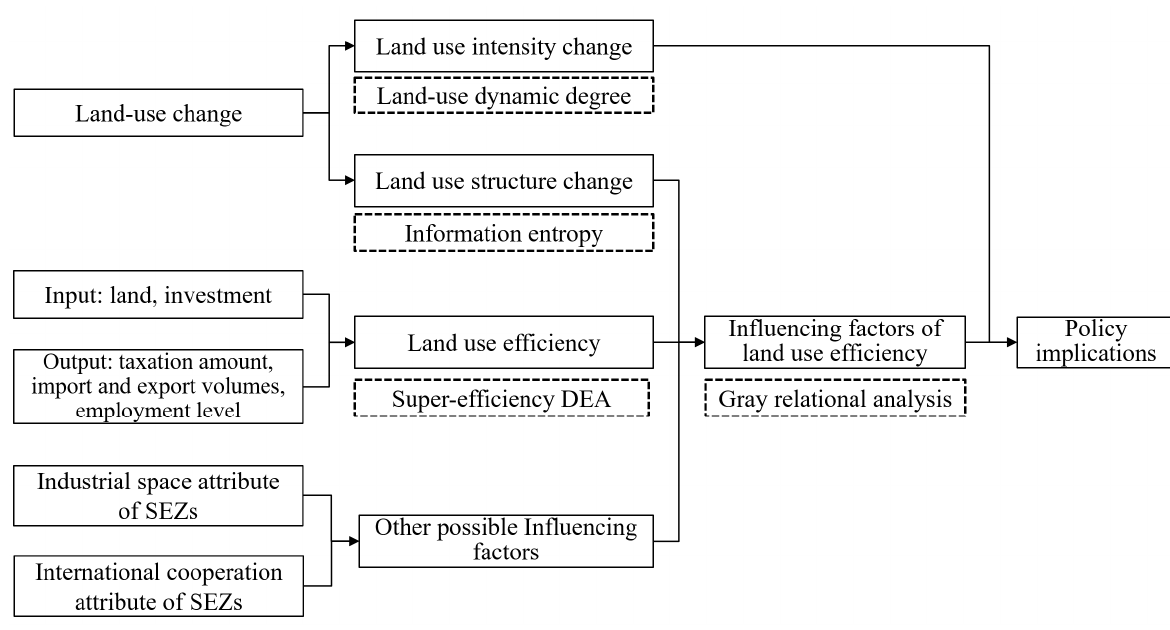
Figure 4. Analytical framework.